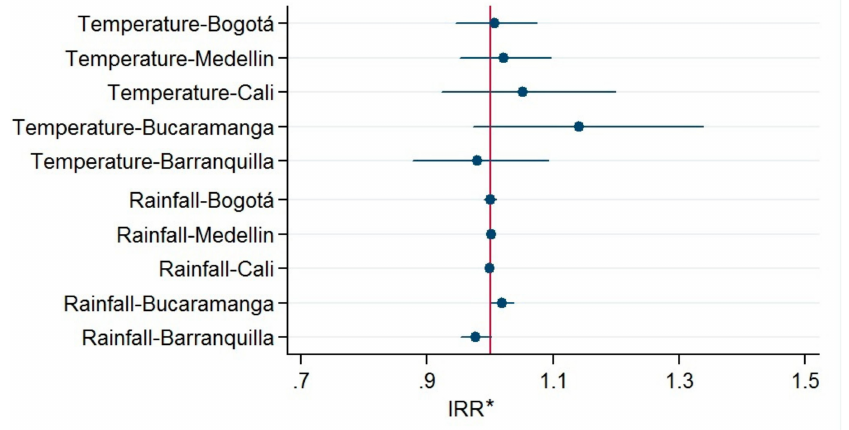
Figure 3. Estimators obtained for the weather variables in the five main cities of Colombia. Estimations were obtained using fixed-effect Poisson models and adjusted for the effect of holidays. *IRR can be interpreted as the average change in the suicide rate for each increment of one unit un each independent variable (a degree in the case if temperature, a cubic millimeter in the case of